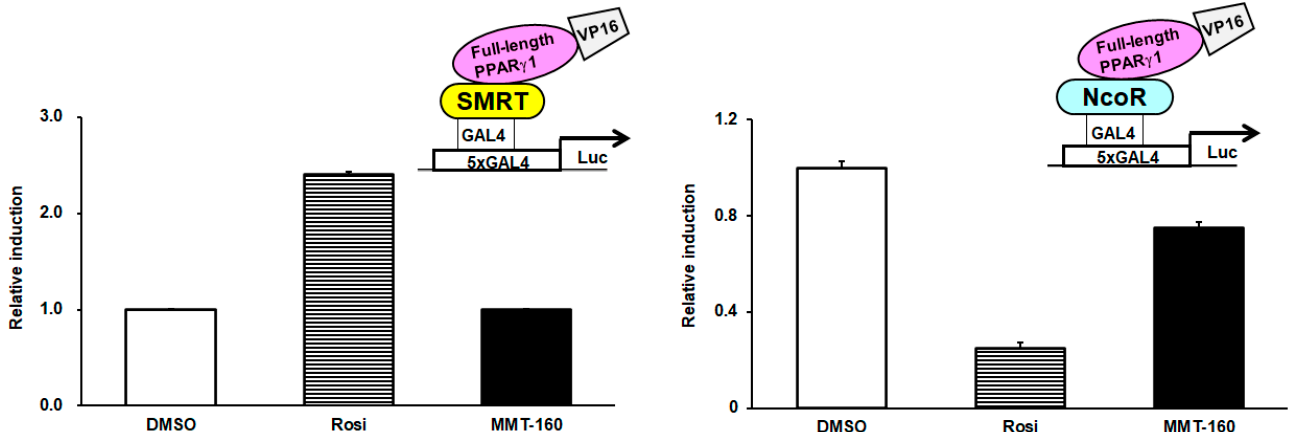
Figure 8. The functional analysis of the hPPAR γ ligands using a mammalian two-hybrid assay. Data are presented as the fold induction relative to the DMSO control. Rosiglitazone (Rosi) was used at 30 µ M and MMT-160 was used at 10 µ M. All data points represent the average of triplicates ( ± SD). ( Left ) hPPAR γ –SMRT two-hybrid assay with TK-MH100x4-LUC was performed in COS-1 cells. Transient transfection with VP16-PPAR γ and Gal4-SMRT. ( Right ) hPPAR γ –NCoR two-hybrid assay with TK-MH100x4-LUC was performed in COS-1 cells. Transient transfection with VP16-hPPAR γ and Gal4 ‐ NCoR.